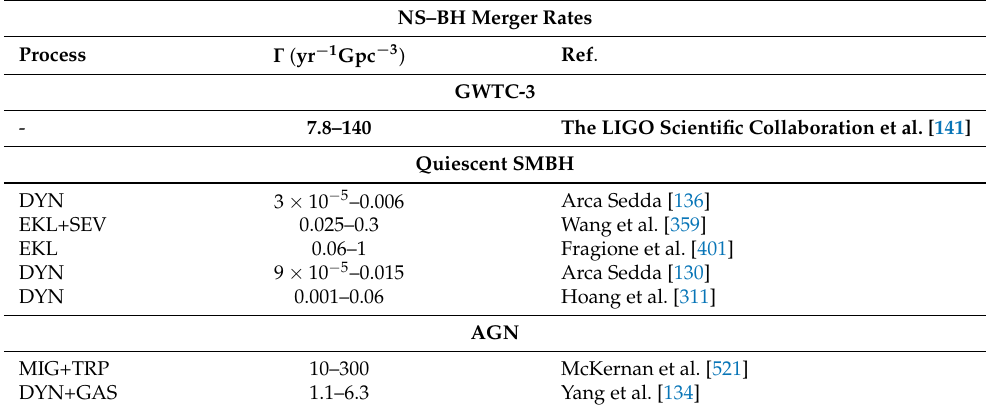
Table 2. Same as in Table 1, but for NS–BH binaries. Note that the estimate from McKernan et al. [521] was obtained under the extreme assumption that all BBH mergers originate in